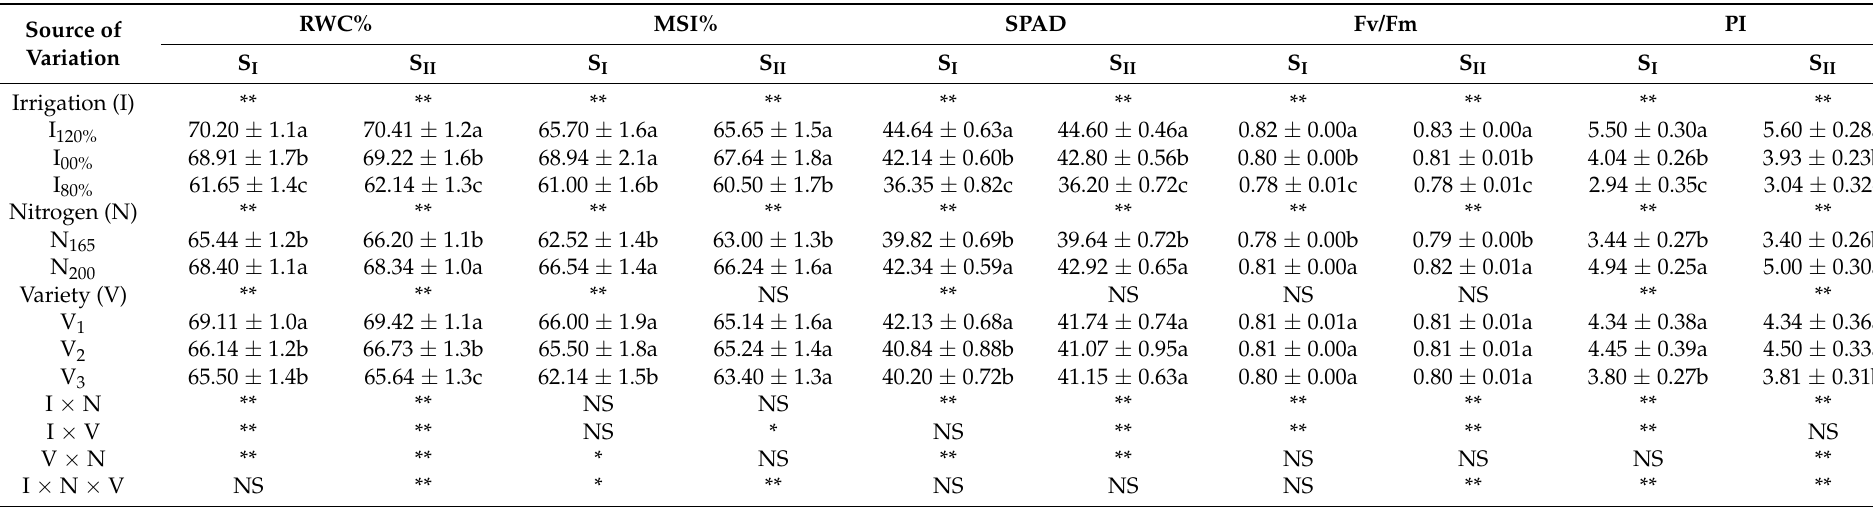
Table 3. Effect of deficit irrigation, nitrogen fertilizer varieties, and their interaction on plant water status (RWC% and MSI %), chlorophyll florescence (Fv/Fm and PI), and leaf chlorophyll content (SPAD) of rice plants in 2017 (S I ) and 2018 (S II )